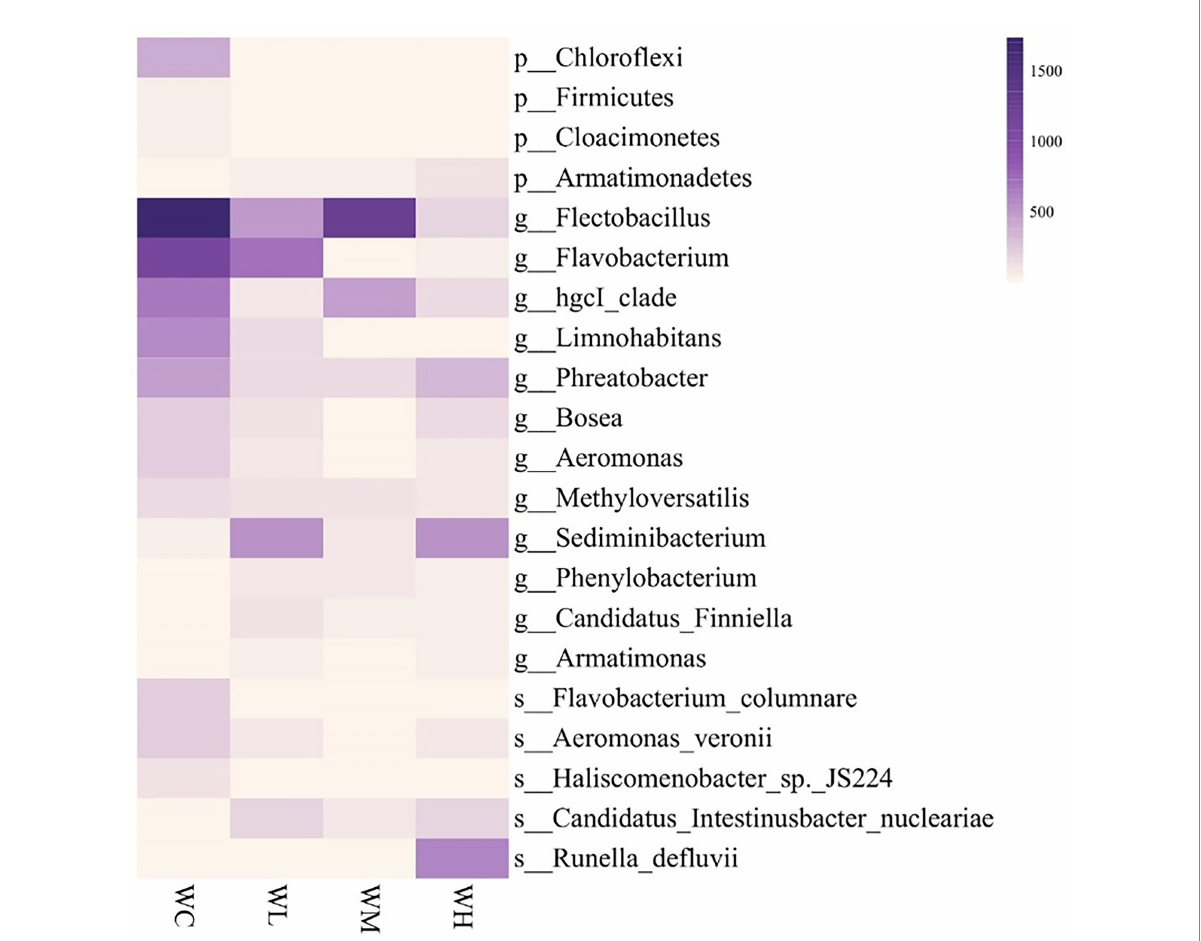
FIGURE 5 Heatmap analysis of top 50 identified bacterial taxa with significantly varied abundance in zebrafish culture water. WC, WL, WM, and WH indicate four culture water treatments with different concentrations of AVH-AgNPs: 0, 6.23, 9.35, and 18.70 μ g/l, respectively. p-, g-, and s-represent classifications at phylum, genus, and species levels, respectively (Duncan test, p <